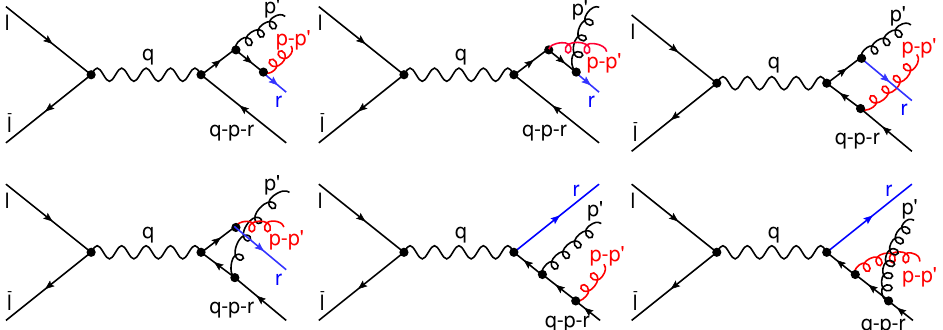
Figure 10. NLO corrections from quark radiation to gluon-gluon